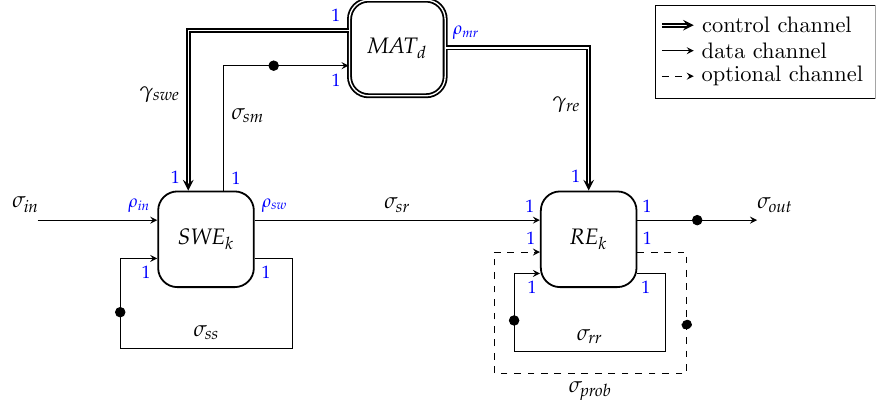
Figure 4. LZMA high level modeling dataflow graph based on SADF model of computation (MoC). Initial tokens are represented by •